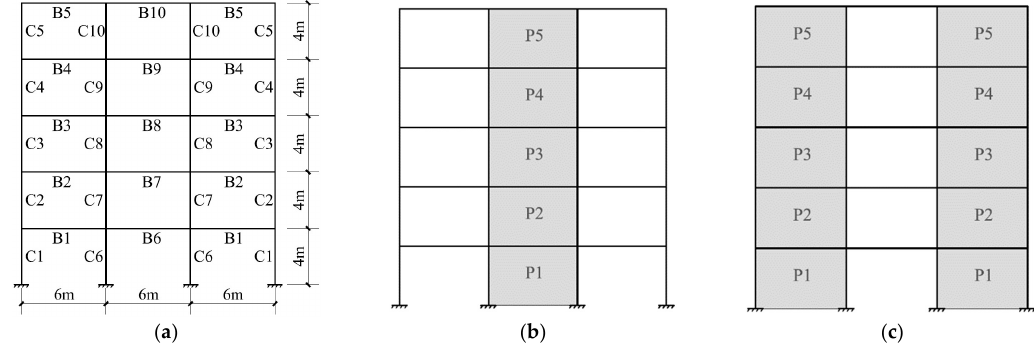
Buildings 2022 , 12 , x FOR PEER REVIEW Figure 4. Five-story steel frame: ( a ) element group numbers; ( b ) SPSW1-5; and ( c ) SPSW2-5. Table 4. Genetic parameters of structures with different stories.